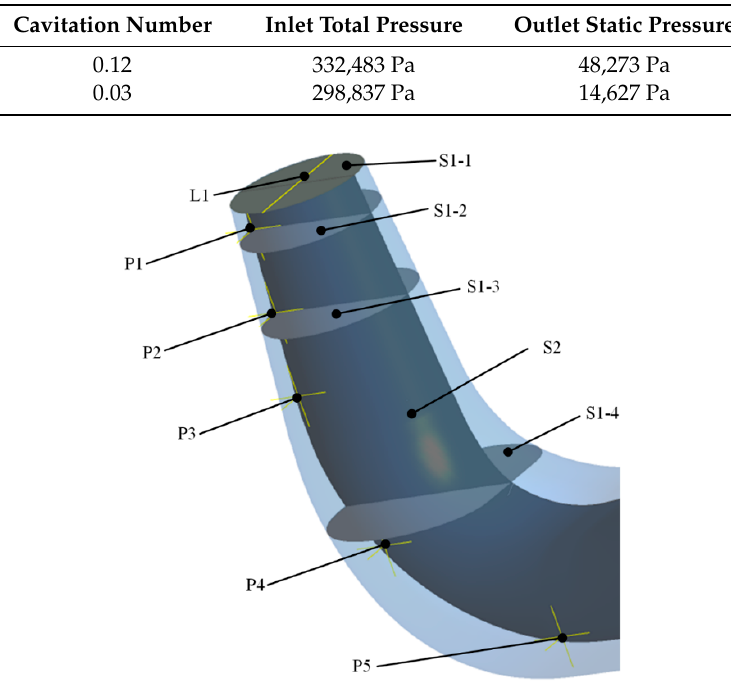
Figure 2. Location of monitoring sections and points.